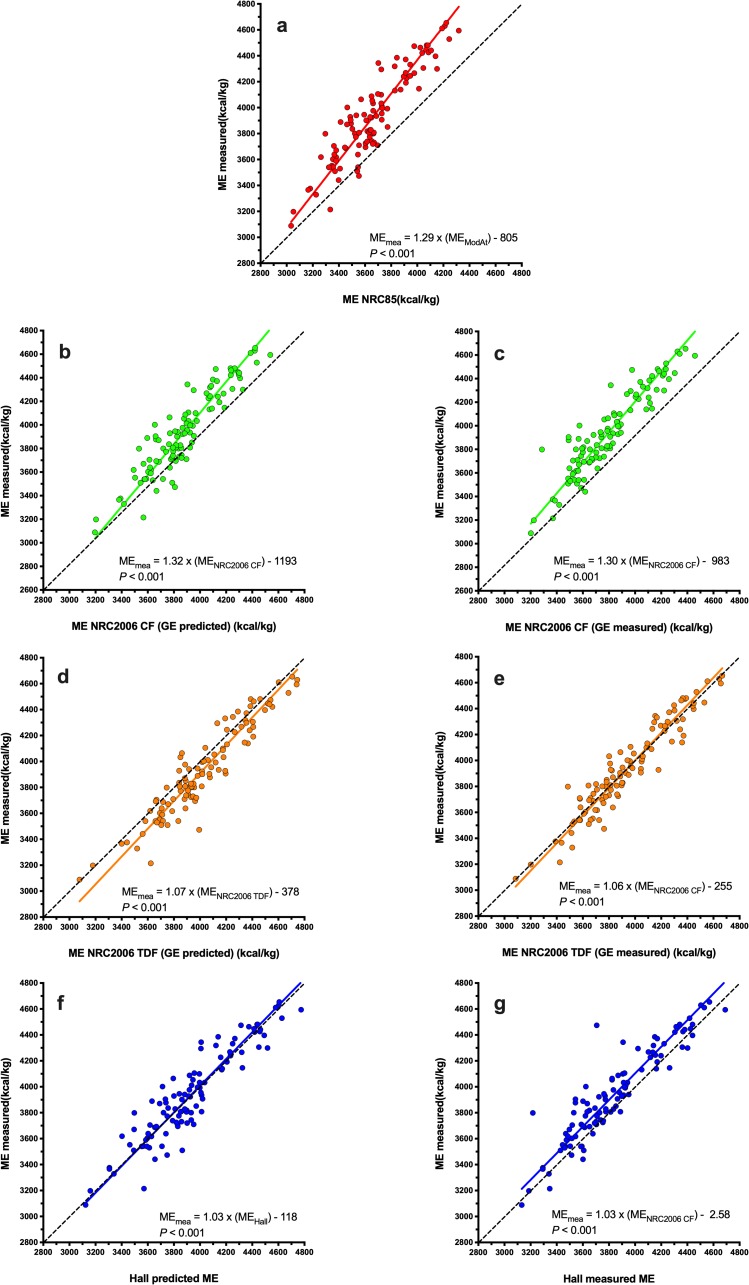
Deming regression plot depicting the relationship between measured and predicted metabolisable energy (ME) content in dry feline diets.The points represent results for individual foods, the solid line depicts the trendline from Deming regression, and the dotted black line represents the line of equivalence (where each unit increase in predicted ME equates to the same increase in measured ME. Different figures represent predictions made with MA (red, a), NRC 2006cf (green, b: predicted GE; c: measured GE), NRC 2006tdf (orange; d: predicted GE; e: measured GE), and Hall equations (blue; f: predicted GE; g: measured GE).